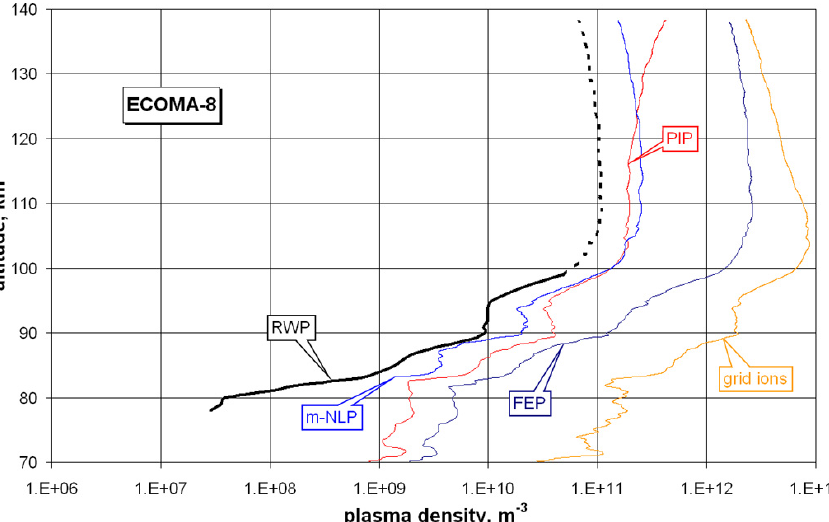
Fig. 6. As Fig. 3, but flight ECOMA-8. The dotted line is an extension of the RWP data primarily relying on the normalised data from the forward electron probe FEP and the multi-needle probe